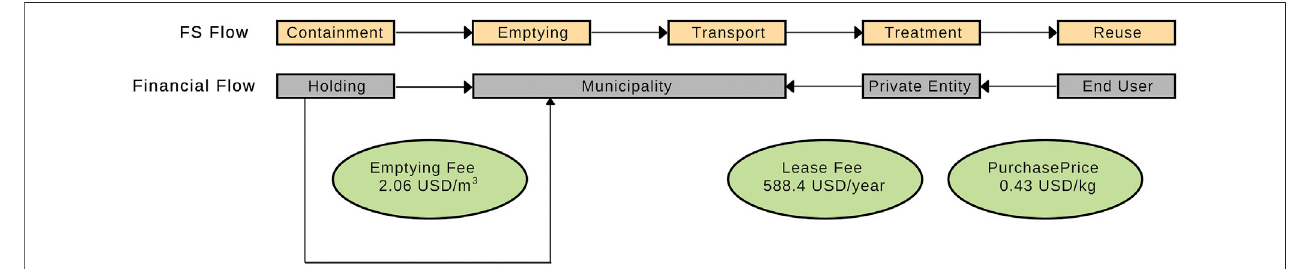
FIGURE 1 | Financial fl ows in the existing